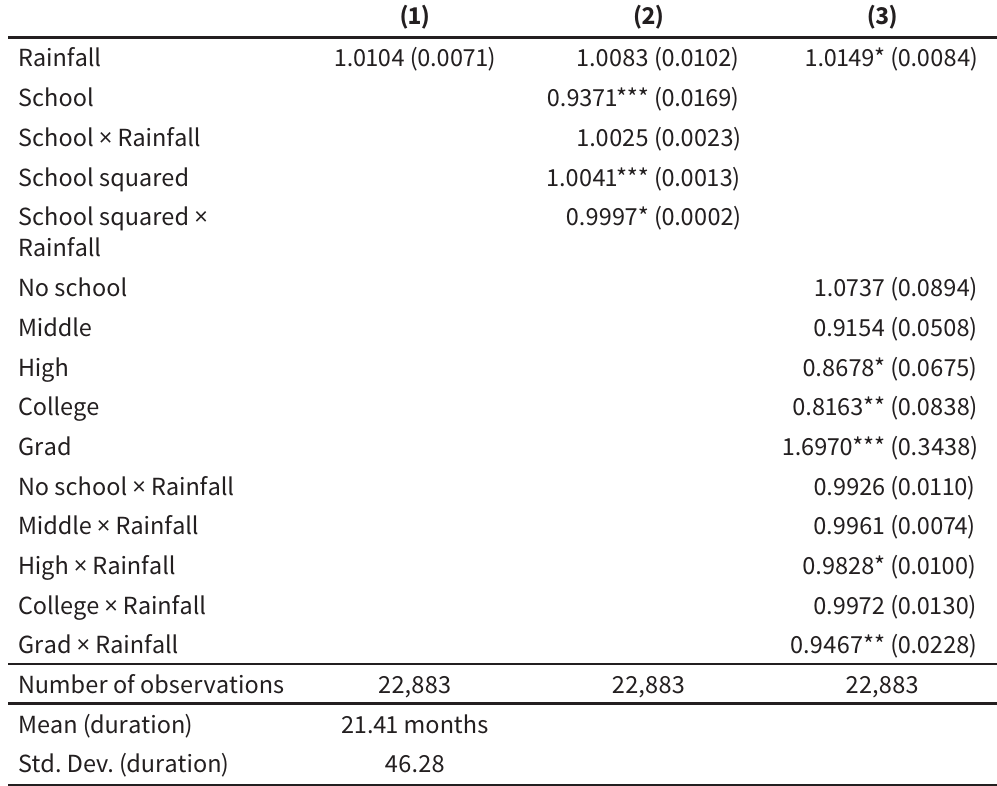
Cox model results: migration duration changes with rainfall (selected